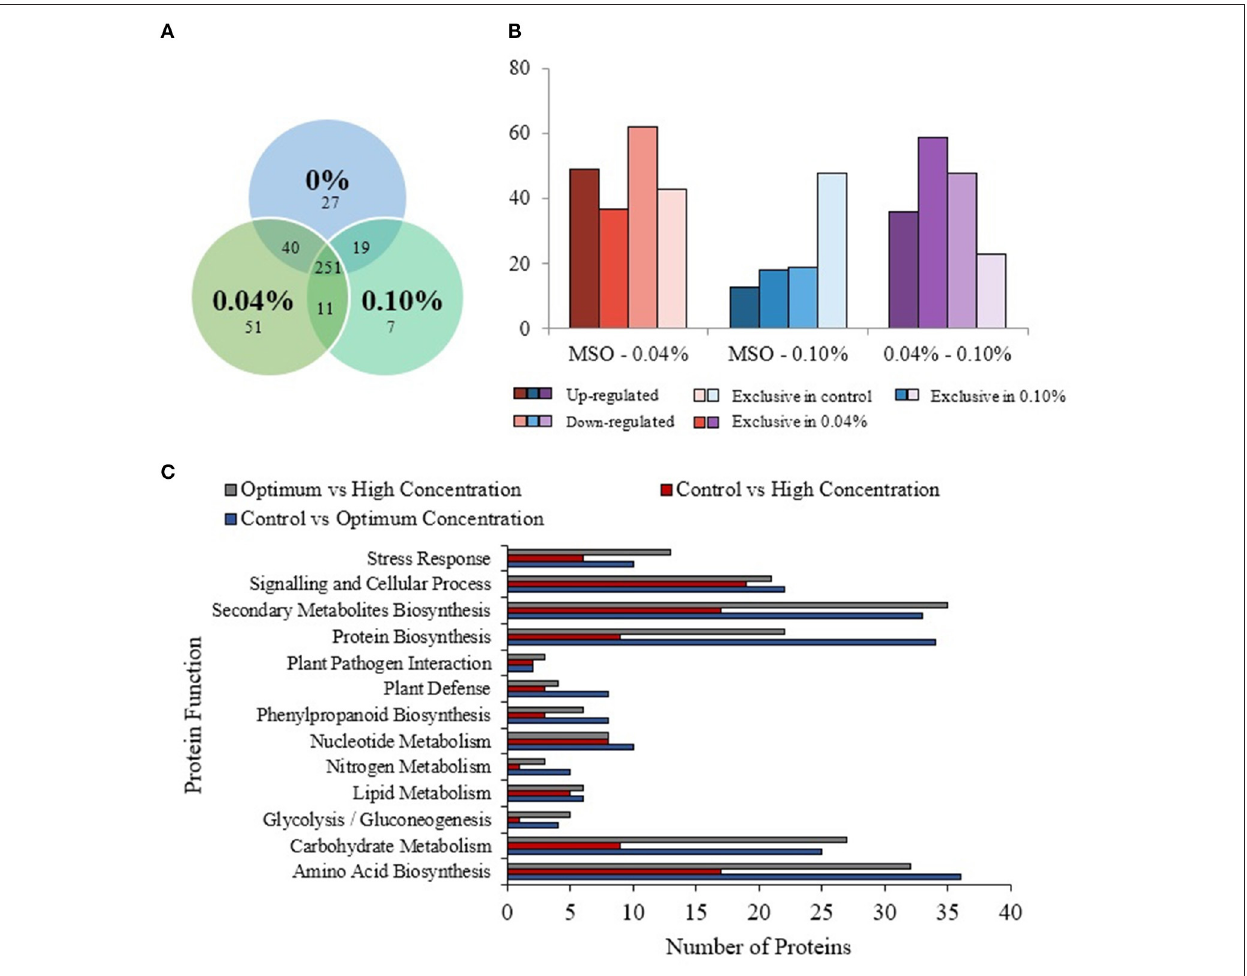
FIGURE 4 | Comparative proteomic analysis of extracts from calli exposed to different PF-68 concentrations. Control (0% PF-68), optimum (0.04% PF-68), and high (0.10% PF-68). (A) Venn diagram of the total proteins obtained from the comparison between three treatments. (B) Total differentially expressed proteins identified in three treatment groups. (C) KEGG-pathway analysis of differentially expressed proteins identified in three treatment groups.